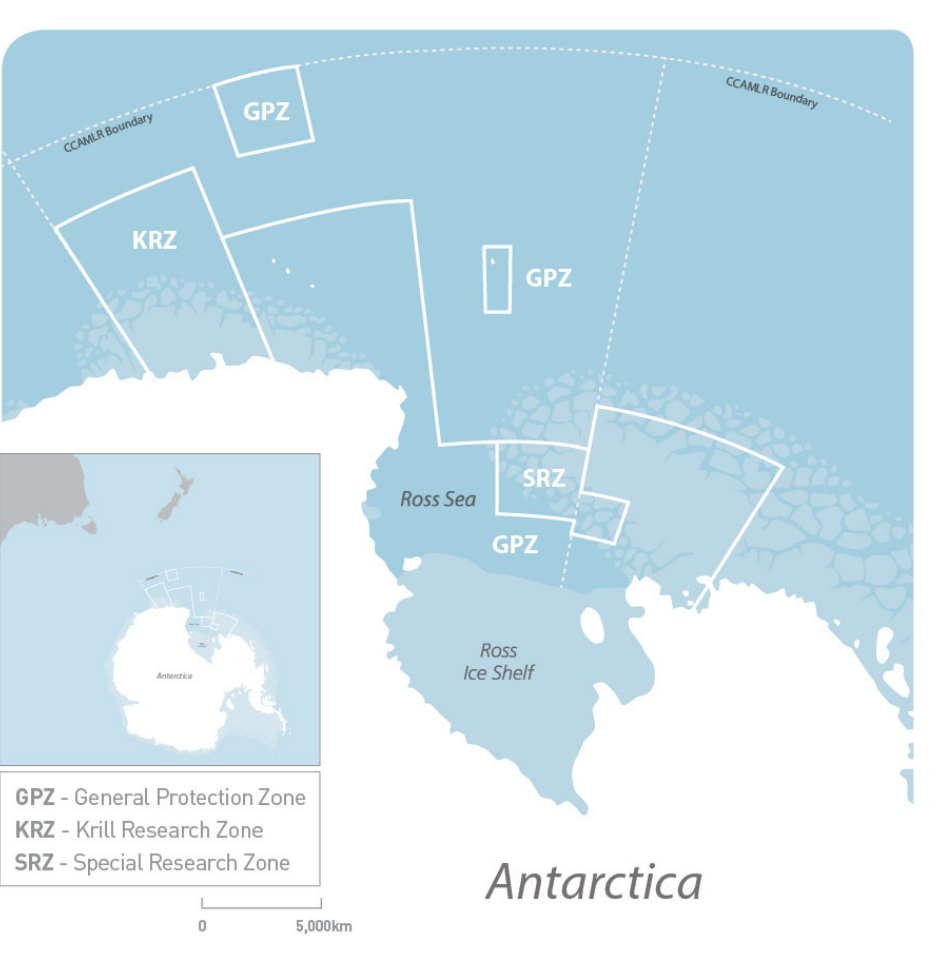
Figure 2. Map of the Ross Sea marine protected area (Source: https://www.mfat.govt.nz/en/environ ‐ ment/antarctica ‐ and ‐ the ‐ southern ‐ ocean/ross ‐ sea ‐ region ‐ marine ‐ protected ‐ area/ (accessed on 8 March 2023)).